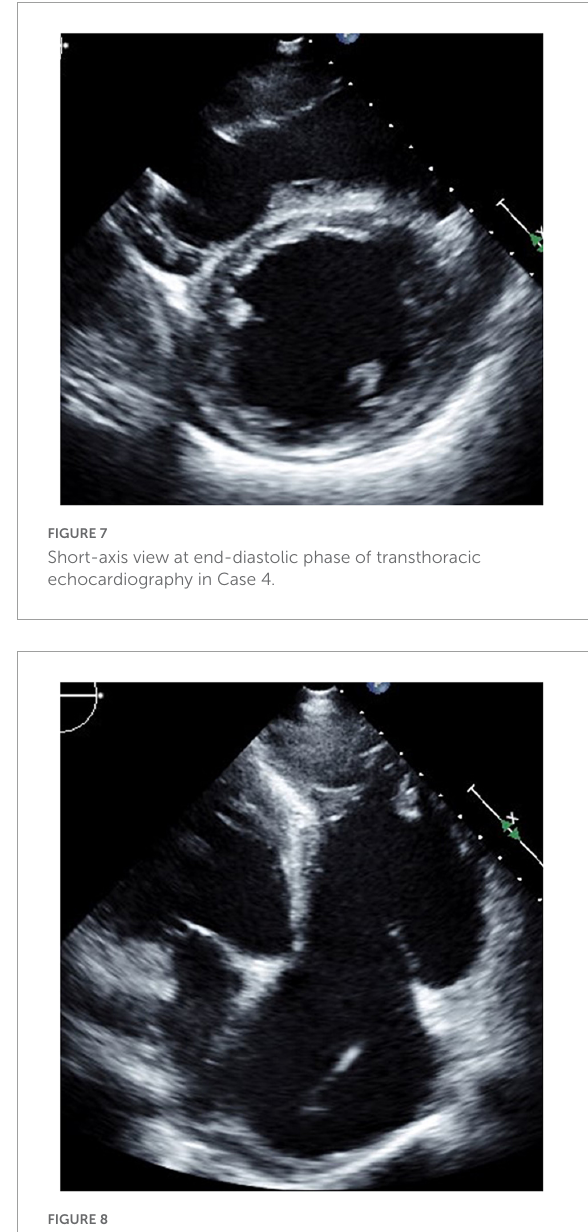
FIGURE8 Four-chamber view at end-systolic phase of transthoracic echocardiography in Case 4. Note that the tricuspid valve does not close at all, and the right atrium is hugely